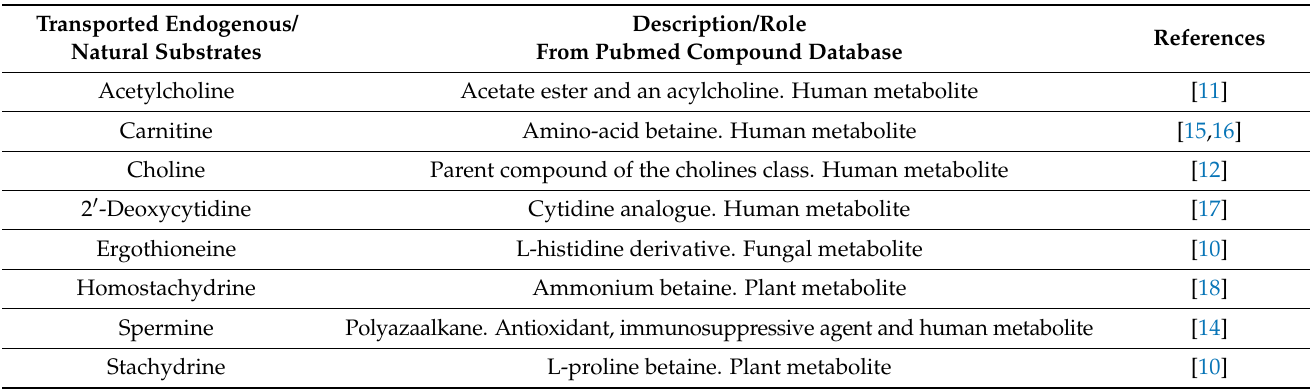
Table 1. Endogenous and Natural Substrates transported by OCTN1. For each substrate, Descrip- tion/Role and one or more References are